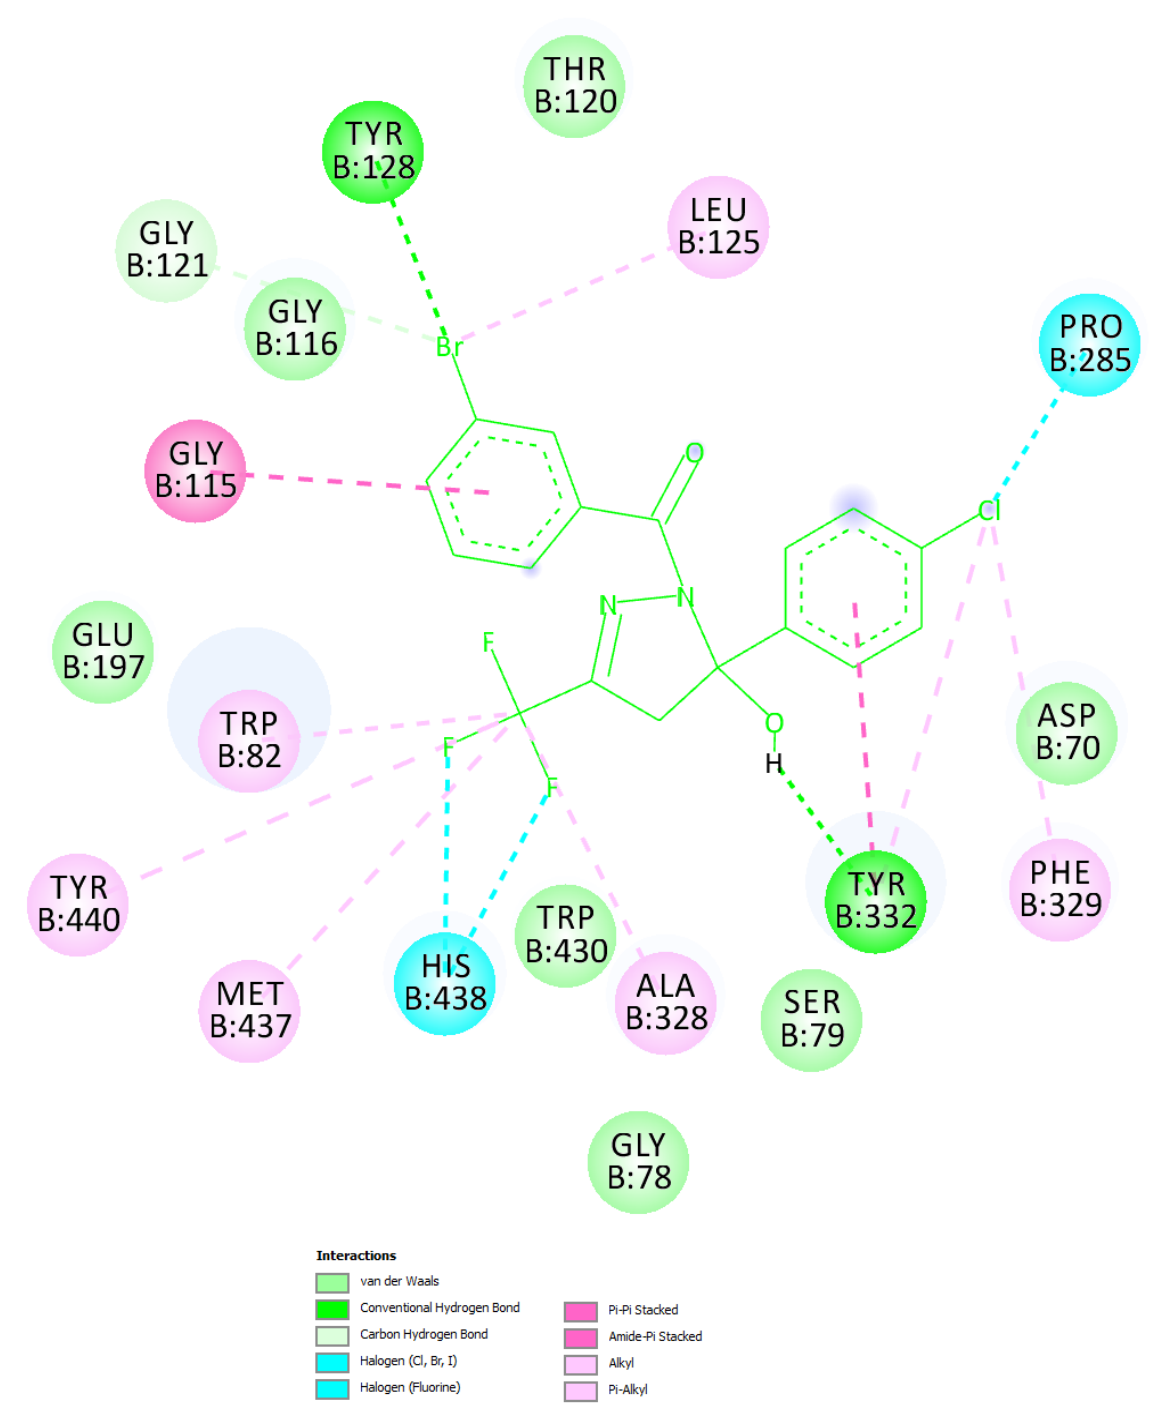
Figure 3: ‘2-D-Diagram’ corresponding to the ‘butyrylcholinesterase-top inhibitor’-complex generated by ‘Discovery Studio Visualizer’